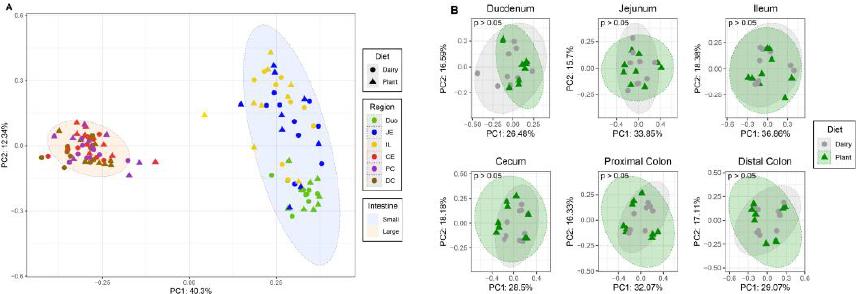
Figure 2. β -diversity in the intestinal contents of piglets fed either a plant- or a dairy-based formula diet. Data generated by 16S rRNA amplicon sequencing targeting the V3 – V4 variable region. ( A )